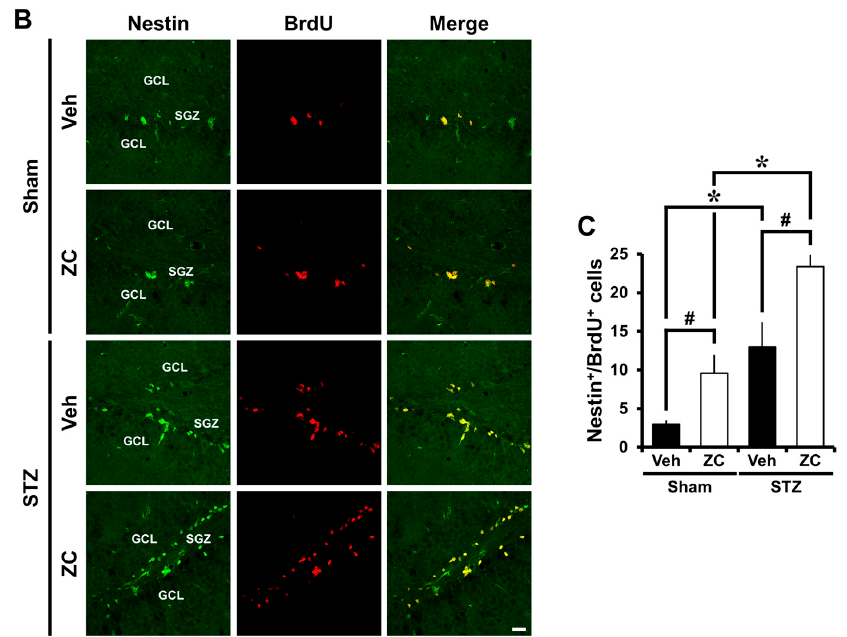
Figure 2. ZC increases neural progenitor cells (NPCs) proliferation in the early phase of STZ-induced diabetic rats. ( A ) Experimental procedure in the early phase of STZ-induced diabetic rats; ( B ) Fluorescent images show Nestin + /BrdU + cells. In the early phase, the STZ-injected group showed a significant increase of Nestin + /BrdU + cells. Short-term ZC treatment increased the number of Nestin + /BrdU + cells in both the sham-operated and the STZ-injected group. Scale bar = 20 µm; ( C ) Bar graph represents the number of Nestin + /BrdU + cells in the SGZ of DG. Data are means ± SE, n = 5–6 from each group. * p < 0.05, versus sham group; # p < 0.05, versus vehicle-treated group. GCL: granular cell layer; SGZ: subgranular zone.